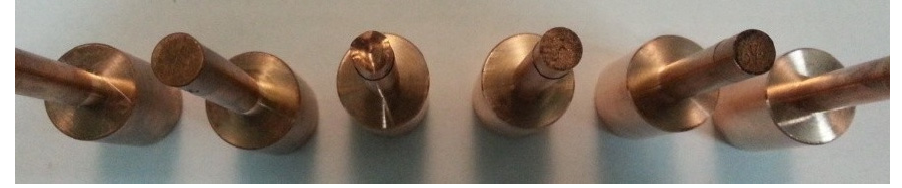
Figure 11. Part of the brazed samples. Table 1. The shear strength for the samples brazed at different